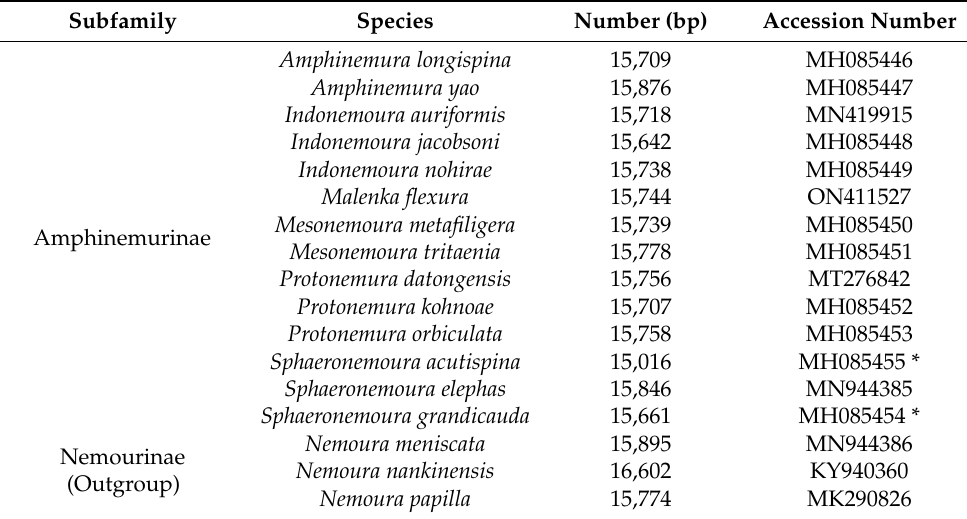
Table 1. General information of nemourid species used in this